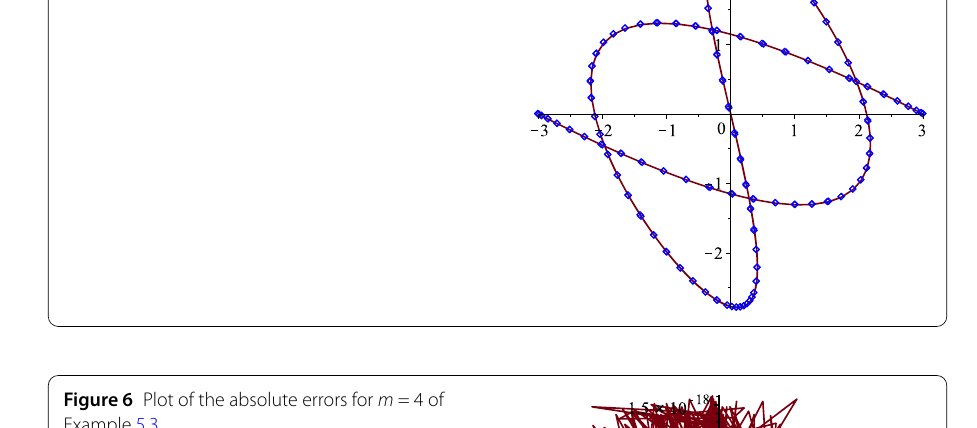
Figure 6 Plot of the absolute errors for m = 4 of Example